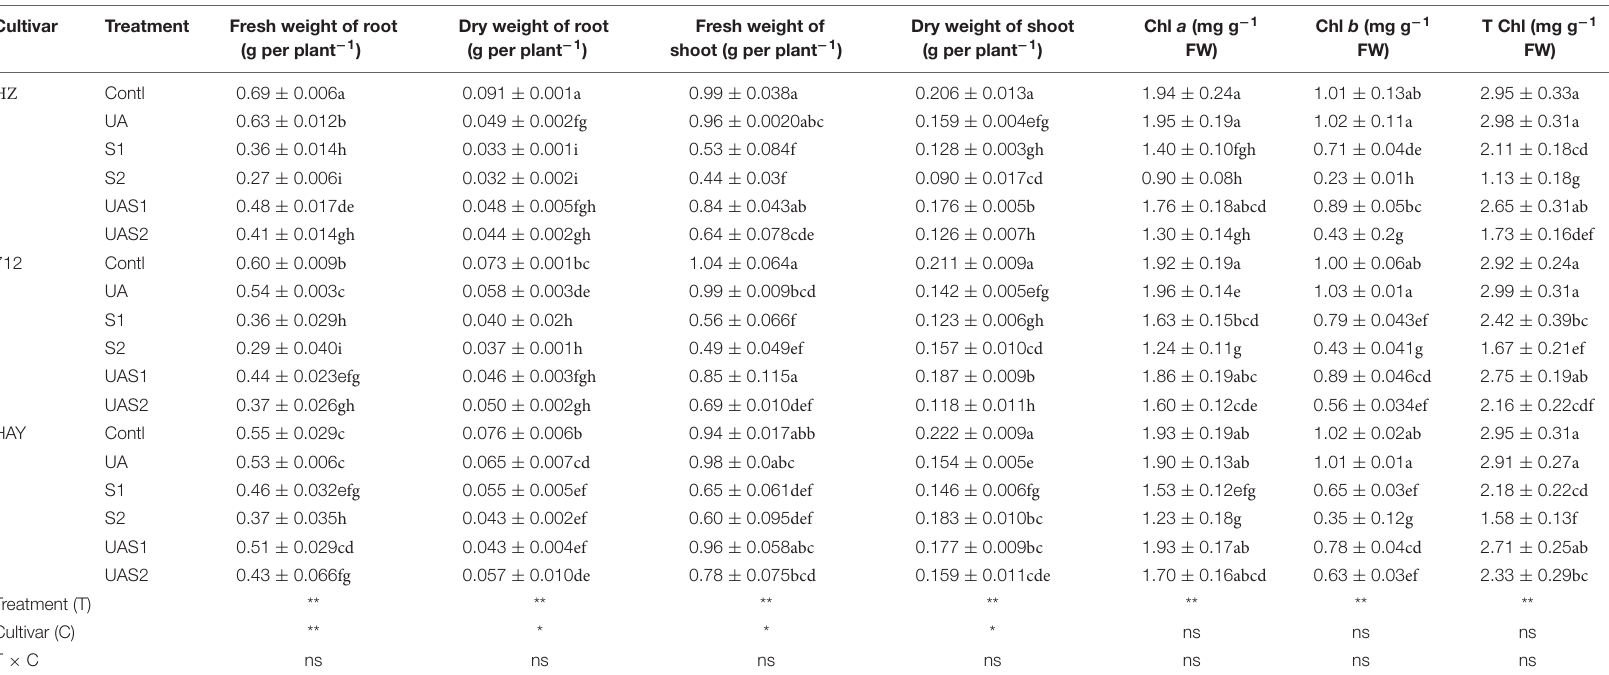
Data are the means of five replicates ± SE, and three/four plants were bulked for each replicate. Values followed by the different letters indicate significant differences based on two-way ANOVA followed by Duncan’s test (p < 0.05) for each cultivar at different saline stress treatments. *p < 0.05; **p < 0.01 level; ns, non-significant. Contl, control; UA-, ursolic acid. S1, 4 dS m − 1 ; S2, 8 dS m − 1 ; UAS1, Ursolic acid + 4 dS m − 1 ; UAS2, Ursolic acid + 8 dS m − 1